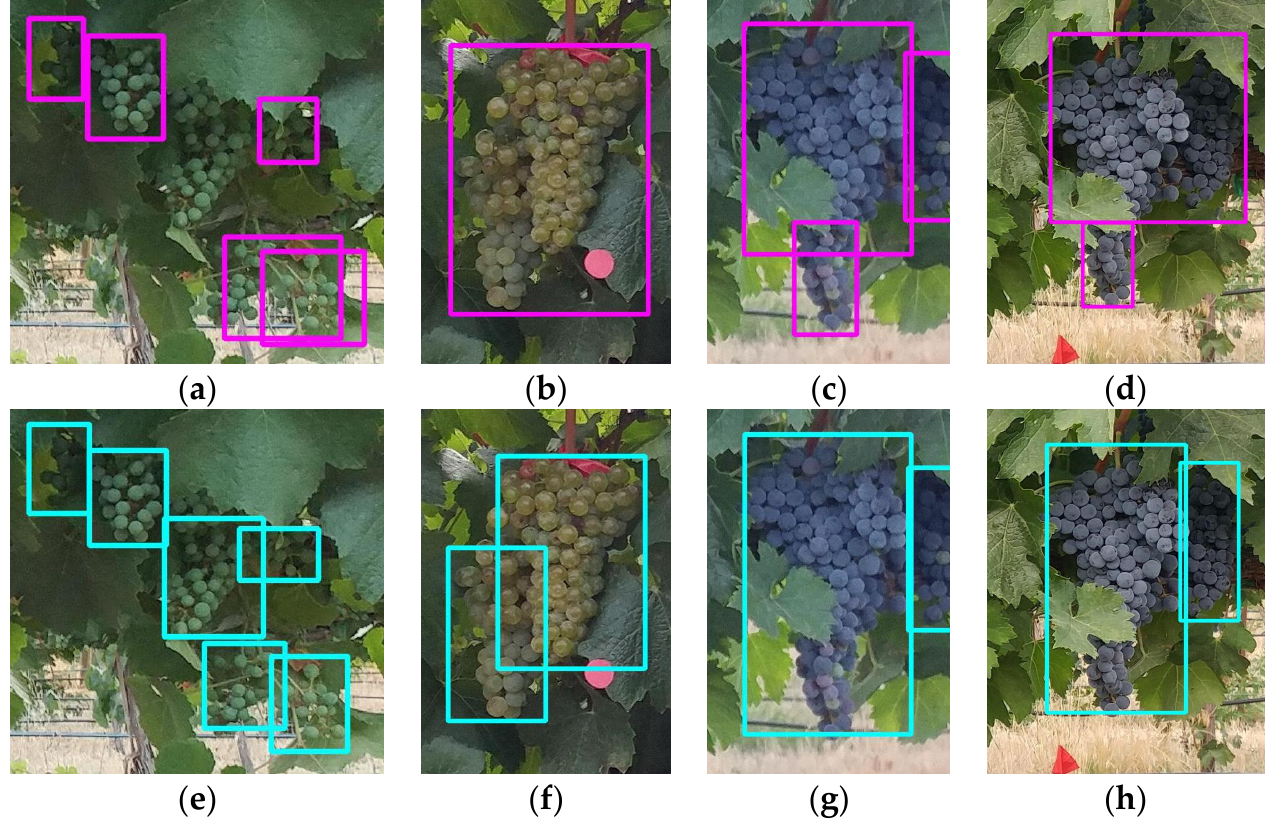
Figure 9. Detection results on Chardonnay (white variety; two columns on the left) and Merlot (red variety; two columns on the right) using ( a – d ) generic YOLOv5 (in magenta color) and ( e – h ) Swin-transformer-YOLOv5 (Swin-T-YOLOv5; in cyan color) in zoomed-in views.